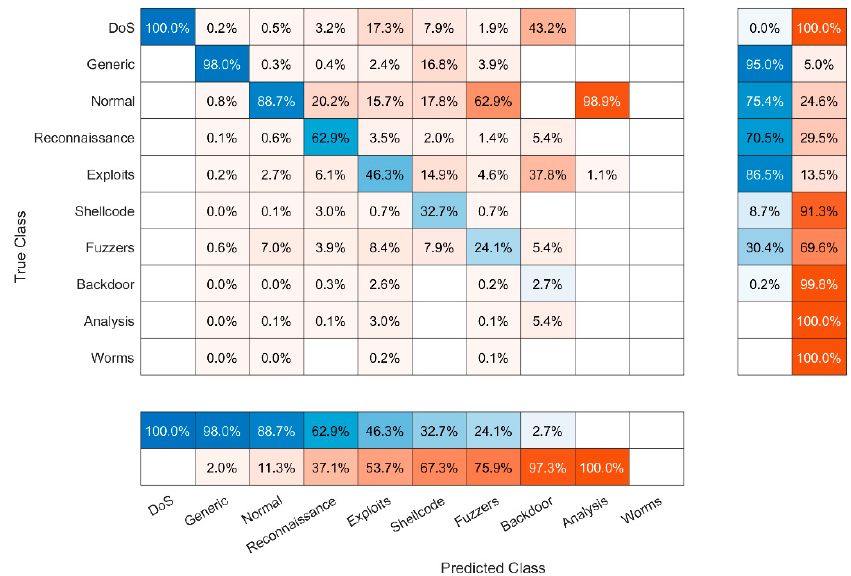
Figure 6. Confusion matrix of detected attacks using ML.NET created model on UNSW-NB15 training dataset.